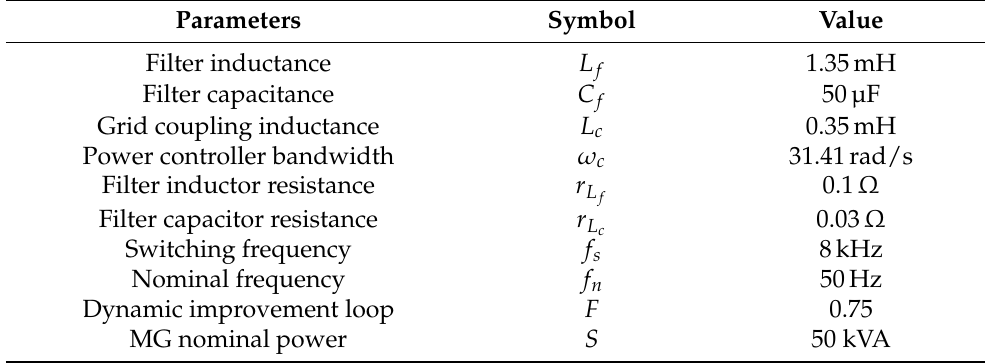
Table 1. The network parameters.